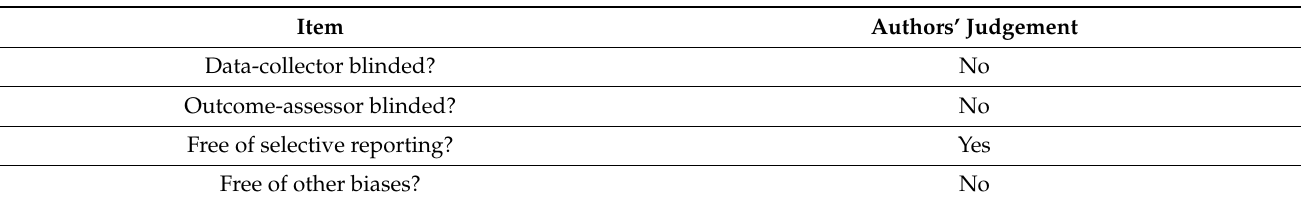
Table A21. Risk of